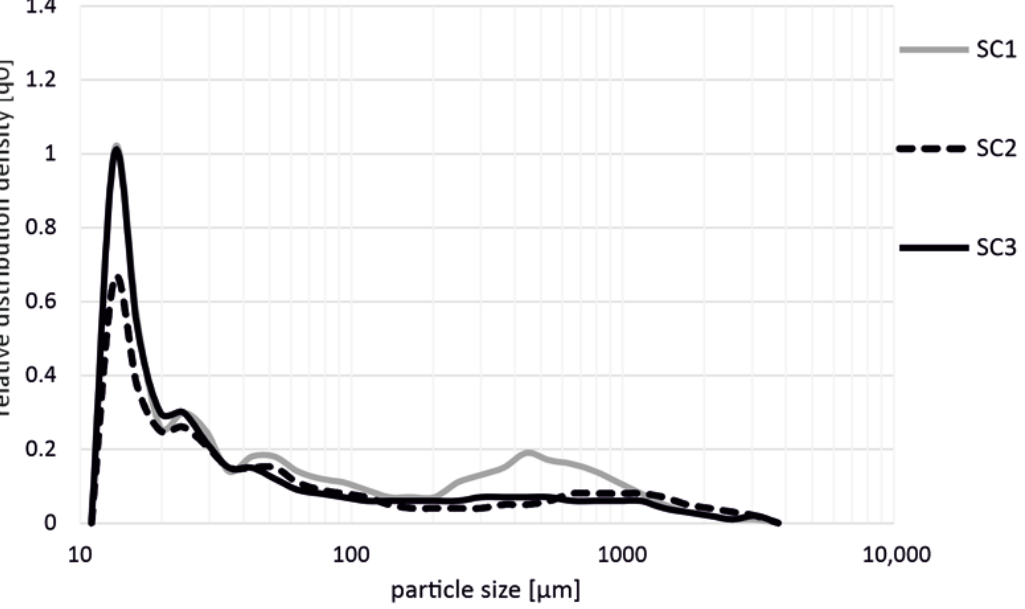
Figure 4. Influence on fiber length during the production of PP GF 40 with different screw configu- rations (SC1, SC2, SC3) in the extrusion process.